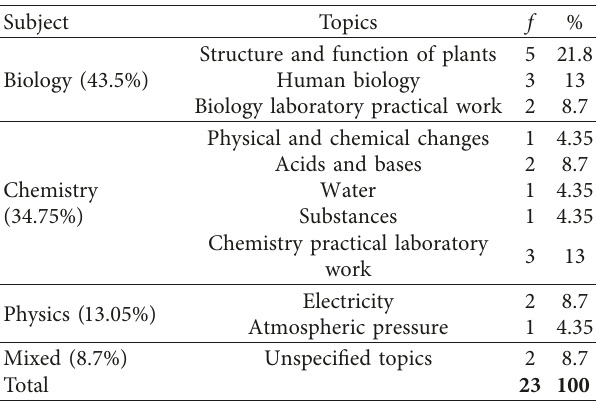
Table 3: Frequently investigated topics in the reviewed IBL papers (2010 to 2021).